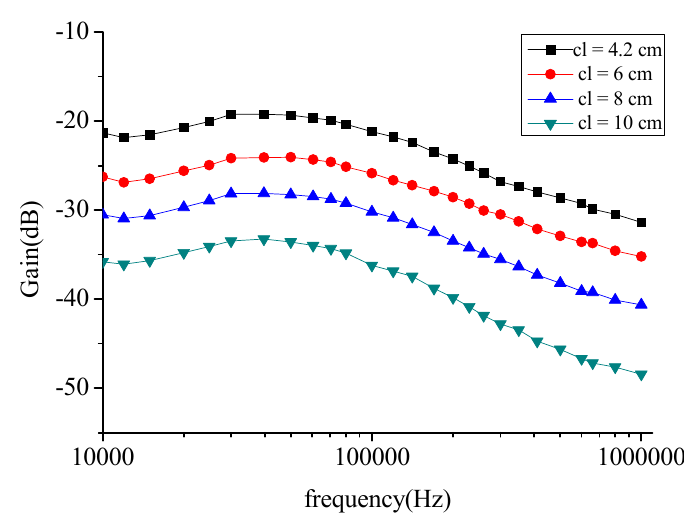
Figure 6. Circuit model channel characteristics for different distances, here the part of the EF and circuit were treated as decoupling in C-EF model.